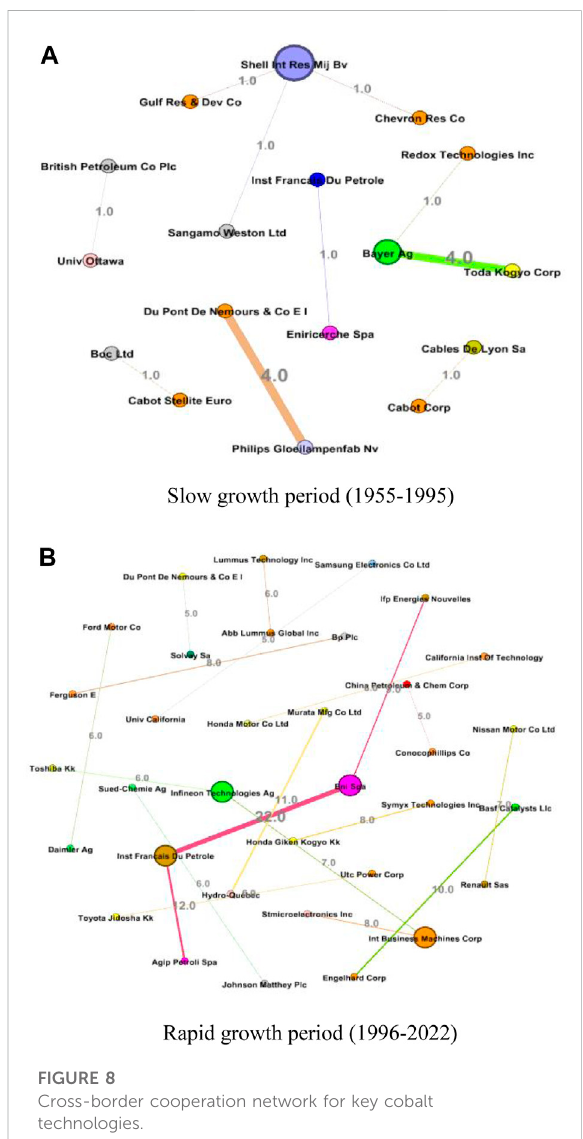
FIGURE 8 Cross-border cooperation network for key cobalt